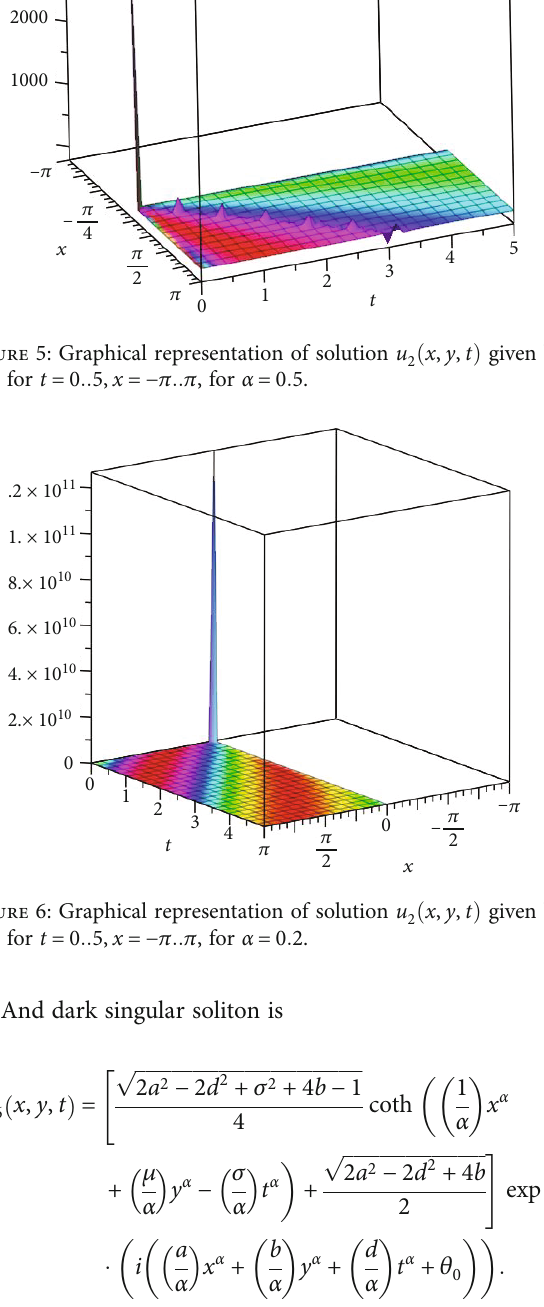
p ffiffiffiffiffiffiffiffiffiffiffiffiffiffiffiffiffiffiffiffiffiffiffiffiffiffiffiffi 2 a 2 − 2 d 2 + 4 b